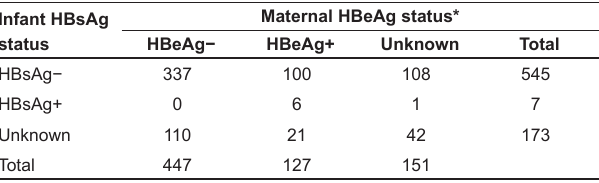
Table 1 Infant (n=725) hepatitis b surface antigen (Hbsag) status at eight to 12 months of age according to maternal (n=715) hepatitis b e antigen (Hbeag) status